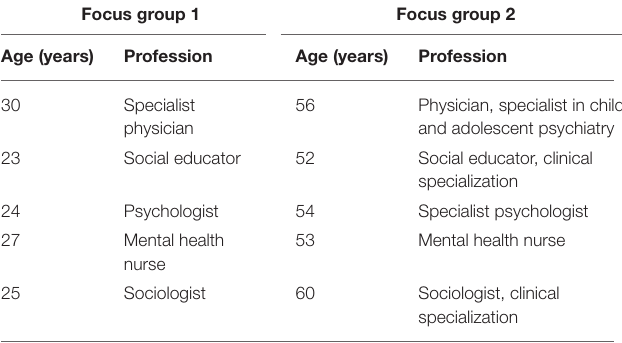
TABLE 1 | Overview of the participants in the focus